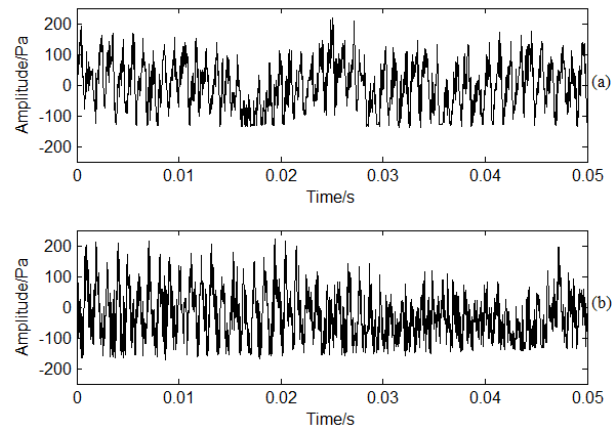
Figure 11. PP time domain signal analysis under different working conditions: ( a ) Normal conditions; ( b ) Crack